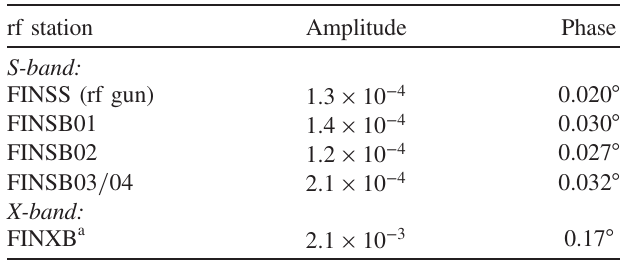
TABLE X. Overview of typical rf stability figures (rms values) over one hour of operation for all rf stations operated at the